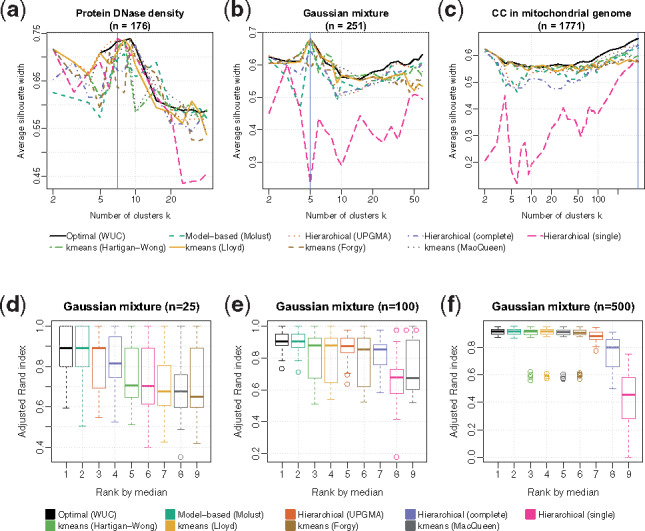
Optimal univariate clustering leads in silhouette cluster quality over heuristic clustering. Heuristic methods include model-based, heuristic k-means and hierarchical clustering in eight configurations. Cluster quality is measured by average silhouette width (ASW) and adjusted Rand index (ARI)—both the higher the better, as a function of number of clusters k. (a) Optical density of protein DNase (n = 176). (b) Simulated data (n = 251) from a five-component Gaussian mixture model. (c) Locations (n = 1771) of CC dinucleotide on the human mitochondrial genome. The blue vertical lines in (a–c) mark the maximum ASW in each plot. (d–f) ranked ARI of each method from the same Gaussian mixture model with (b), in different sample sizes of (d) 25, (e) 100 and (f) 500, each replicated 51 times to produce the box plots